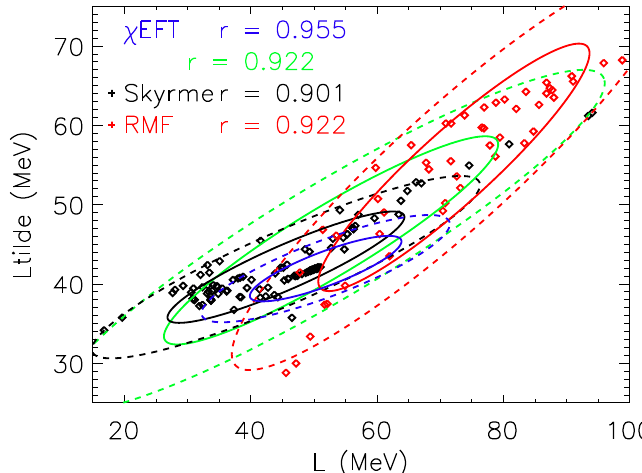
Figure 6. Correlations between ˜ L ( u 1 ) (Ltilde) and L for χ EFT PNM theory (blue), and Skyrme (black) and RMF (red) interactions from Refs. [34,36], respectively. Green ellipses display the combined Skyrme and RMF correlation. Correlation coefficients ( r ) are